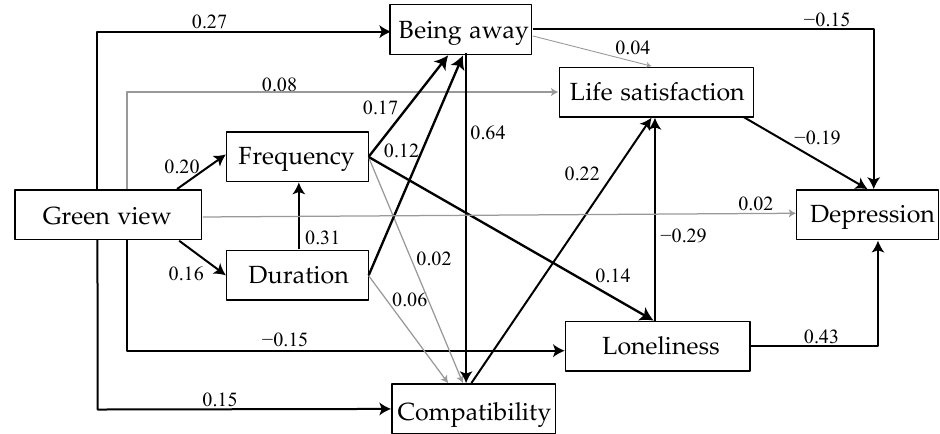
Figure 2. The final SEM model 1 demonstrates standardized effects between variables. Note: The solid black lines indicate p < 0.001, and the gray dotted lines indicate p > 0.05.